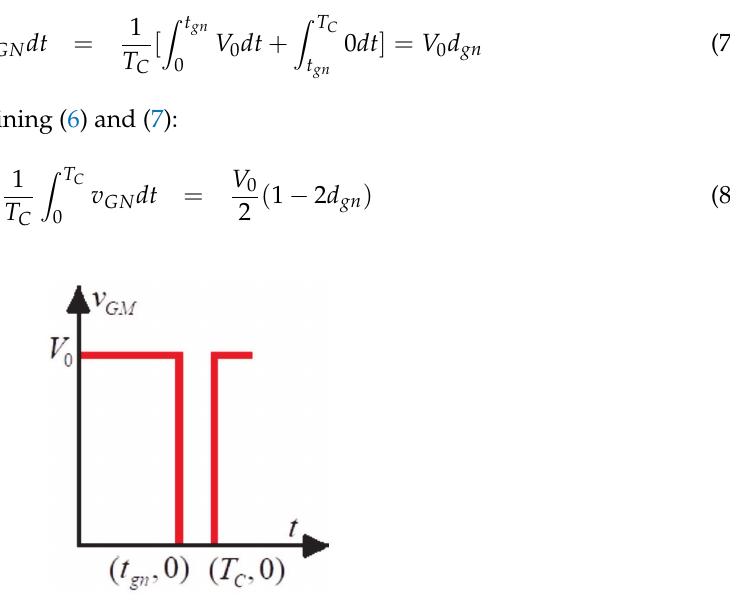
Figure 3. Pole voltage, v GM